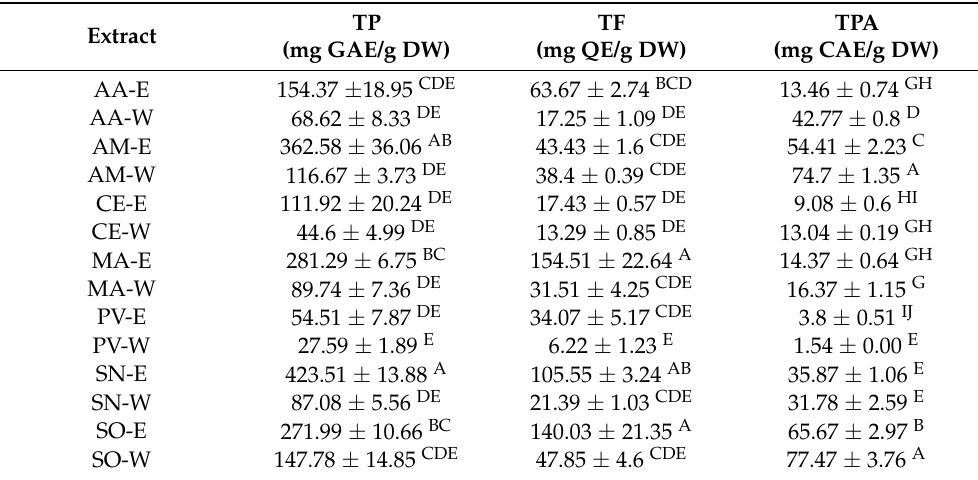
Table 4. Content of total phenols (TP), total flavonoids (TF), and total phenolic acids (TPA) in the